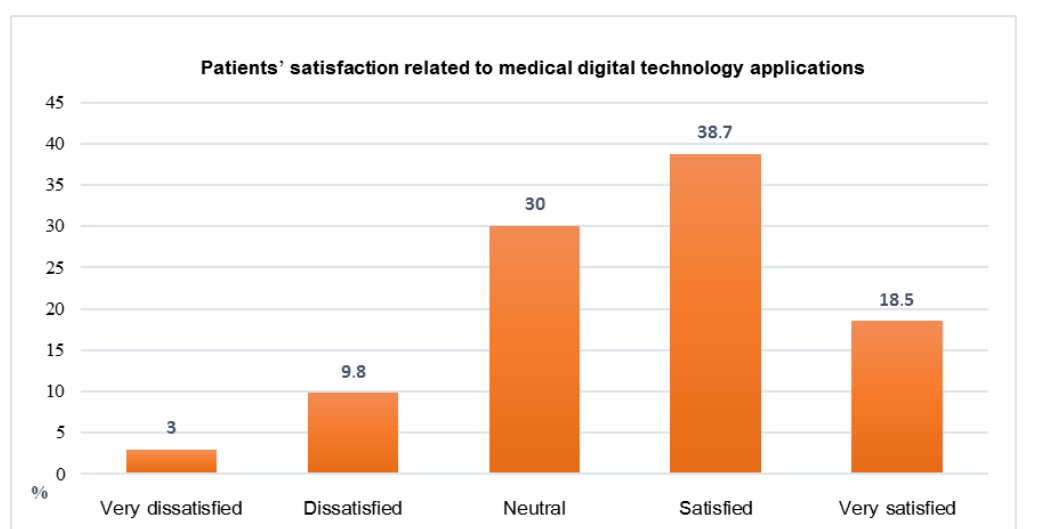
Figure 4. Services of medical digital technologies applications for patients in the study during the COVID-19 pandemic.